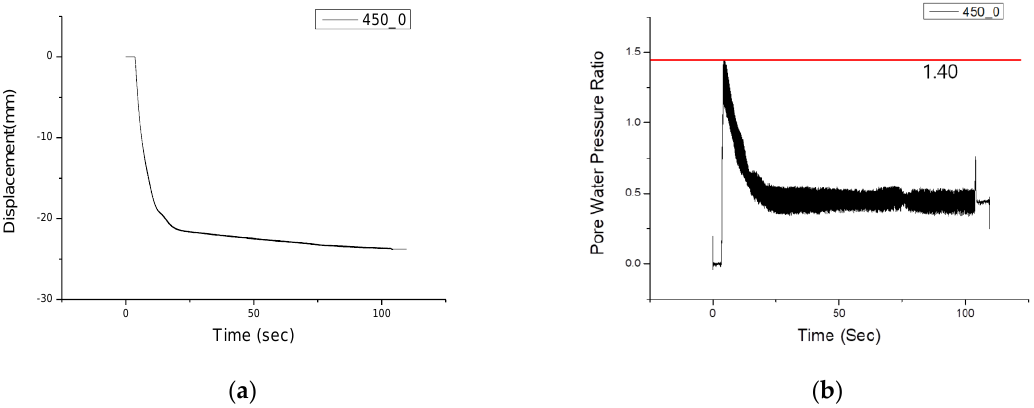
Figure 11. Grouting mixing ratio of 0.45 and separation distance of 0 cm: ( a ) Settlement ( b ) Pore Water Pressure Ratio.